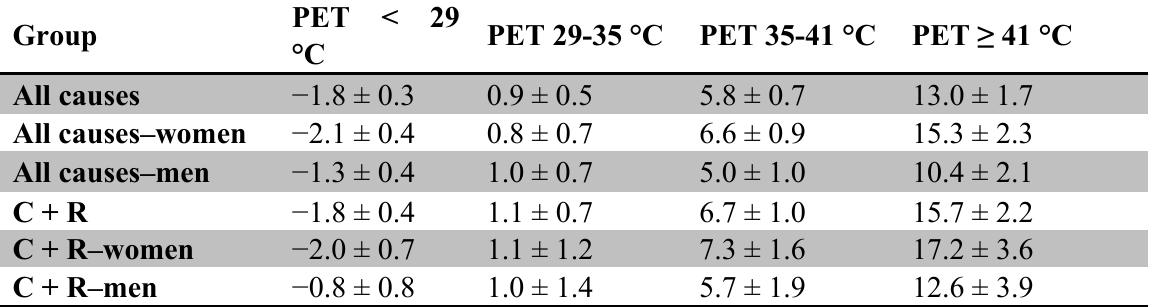
Table 1. Mean relative mortality and confidence interval (%) between 1970 and 2007 for different groups and different grades of thermo-physiological stress. (C + R: cardiovascular and respiratory diseases). PET Group PET 29-35 °C PET ≥ 41 °C